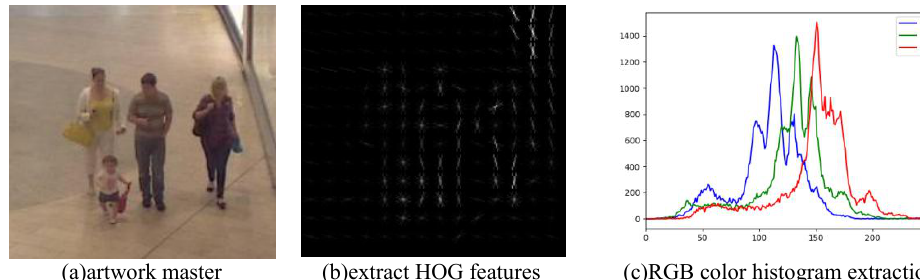
Figure 5 . Feature extraction